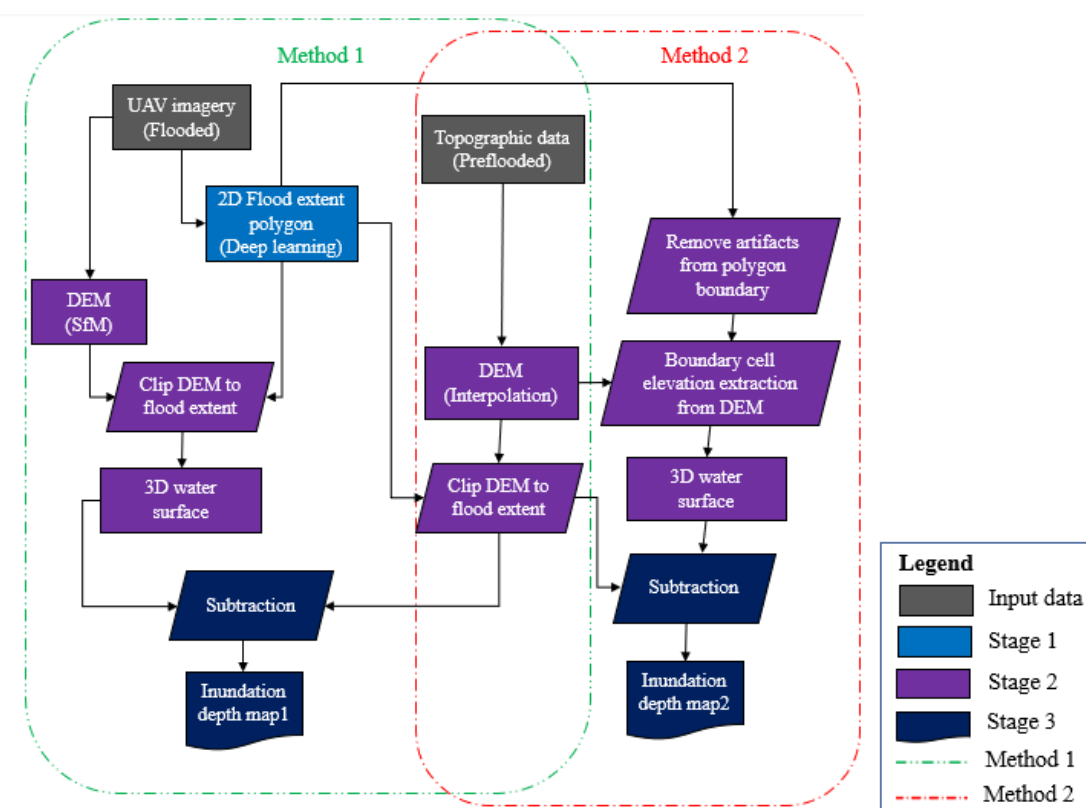
Figure 2. The proposed methods for floodwater depth estimation.